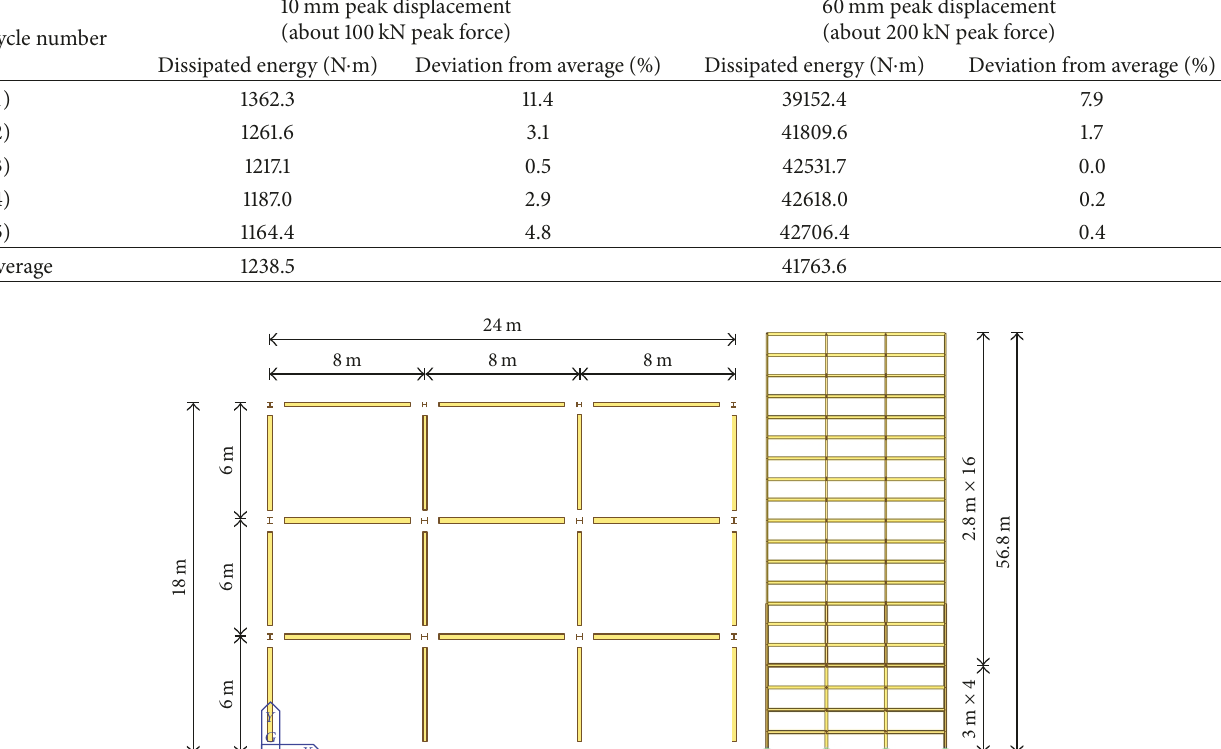
Table 5: Dissipated energy per each loading cycle.